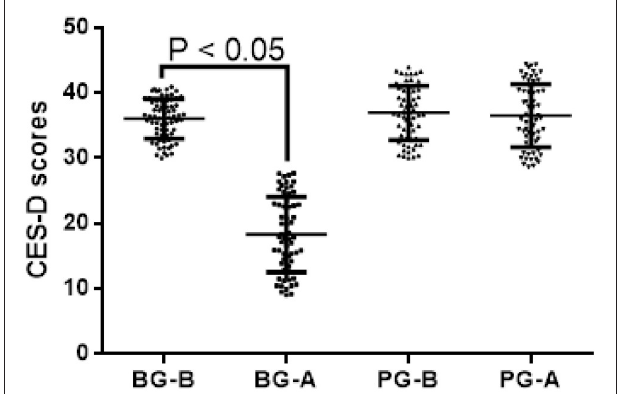
FIGURE 3 | Analysis of Center for Epidemiological Studies Depression Scale (CES-D) for depressive symptoms in CVT patients between BG and PG groups. Higher scores suggest severe depressant symptoms. Cutoff point: the scores are more than 24 points are regarded as depressant patients. BG-B, CES-D scores in CTV patients from BG group before therapy; BG-A, CES-D scores in CTV patients from BG group after therapy; PG-B, CES-D scores in CTV patients from PG group before therapy; PG-A, CES-D scores in CTV patients from PG group after therapy. There is significantly statistical difference if P < 0.05.